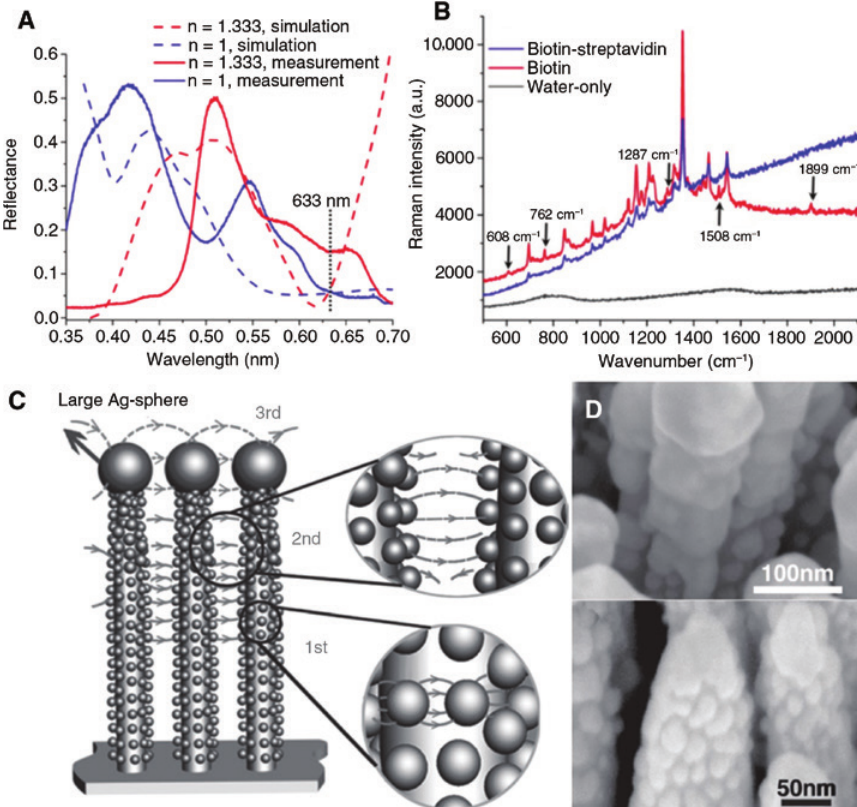
Figure 6: 3D plasmonics SERS sensors. (A) Measured (solid curves) and simulated (dashed curves) FlexBrite in dry state (blue curves) and wet state (red curves). Both measured